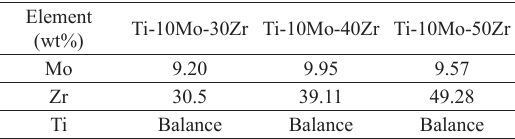
Table 1. Chemical composition of the Ti-10Mo-Zr produced alloys, obtained by EDS. Element (wt%)